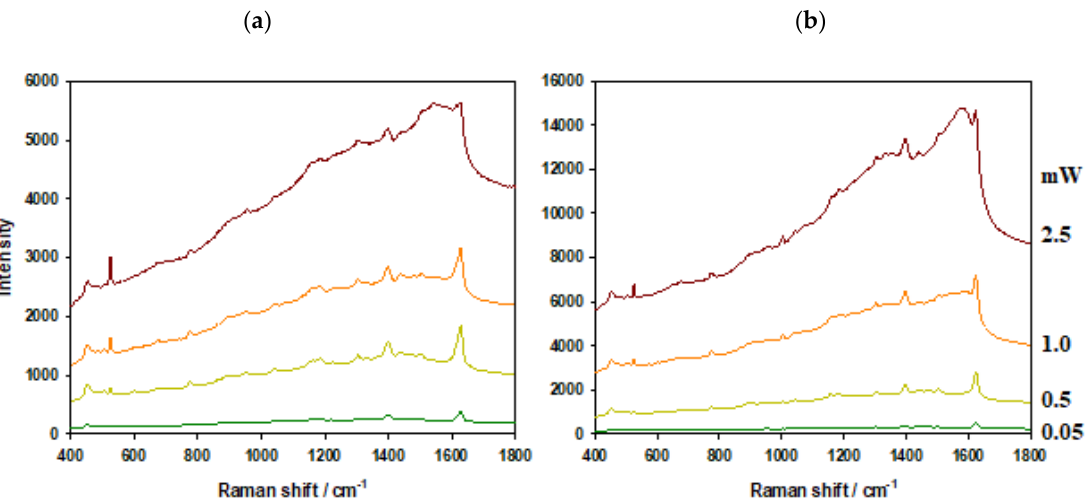
Figure 4. Surface-enhanced Raman scattering (SERS) of 0.1 μM methylene blue (soaking concentration), ( a ) AuSiO 2 and ( b ) AuPS substrates. Laser power at the sample from bottom to top: 0.05, 0.5, 1, 2.5 mW.